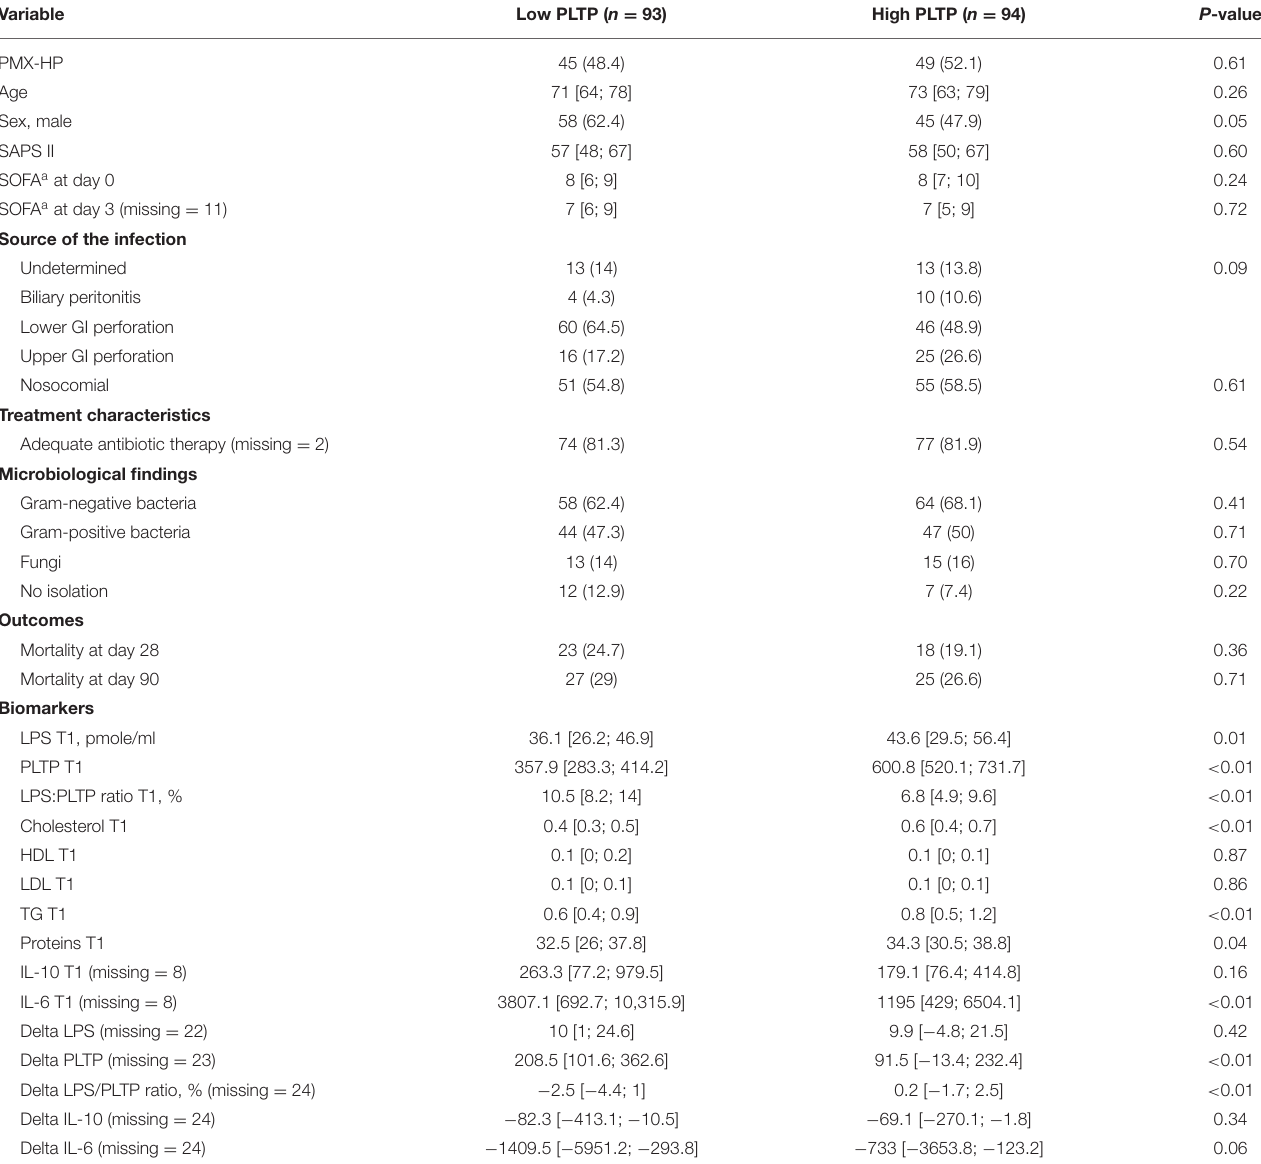
TABLE 3 | Comparison between the patients having a low (infra median) vs. high (supra median) level of PLTP on the whole cohort ( n = 187).